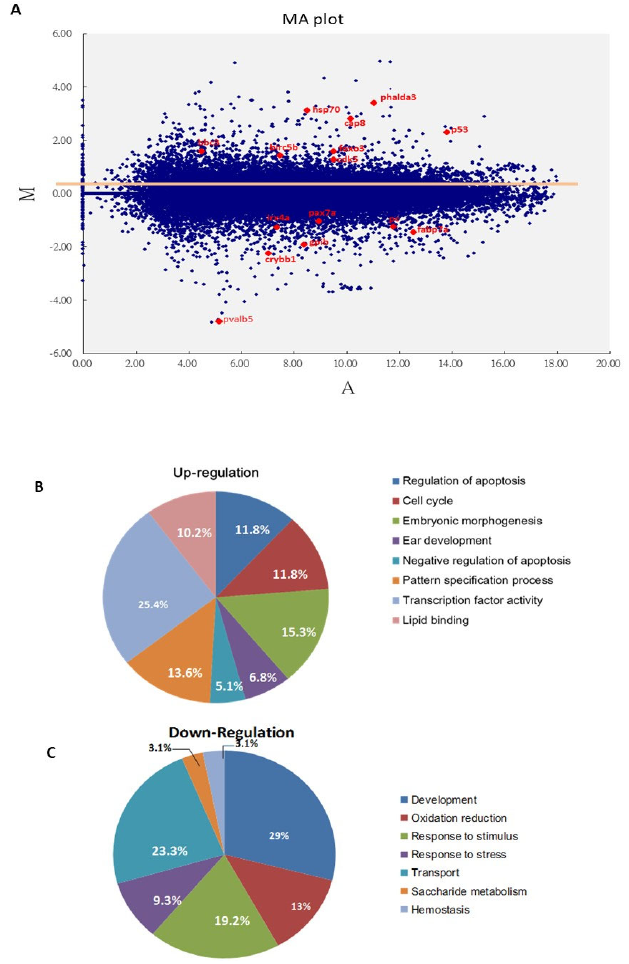
Figure 2. Screening of major cell death pathways via a DNA array approach with Bad knockdown at 24 hpf. ( A ) MA plot showing the distribution of upregulated and downregulated genes in the Bad MO group, with a cut ‐ off of 2 fold changes compared to the Bad M5 group. The key factors p53 and caspase ‐ 8 are upregulated. The brain development genes crybb1 , pva1b5 , irx4a , pax7a , and fabp7a are marked in red. ( B , C ) Changes in biological function genes during loss ‐ of ‐ Bad ‐ mediated PCD are analyzed in separate pie charts for upregulation ( B ) and downregulation ( C ).